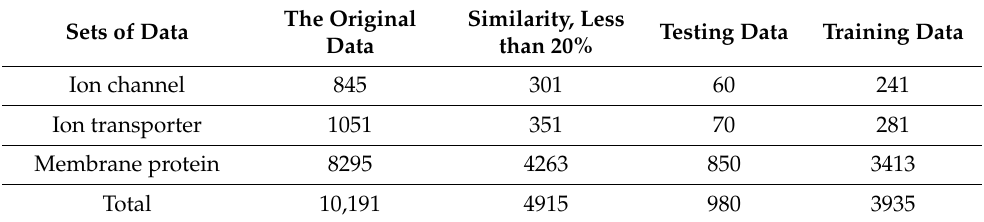
Table 9. The data sets used in this experiment. Due to copyright issues, the table is reconstructed using data from ref.